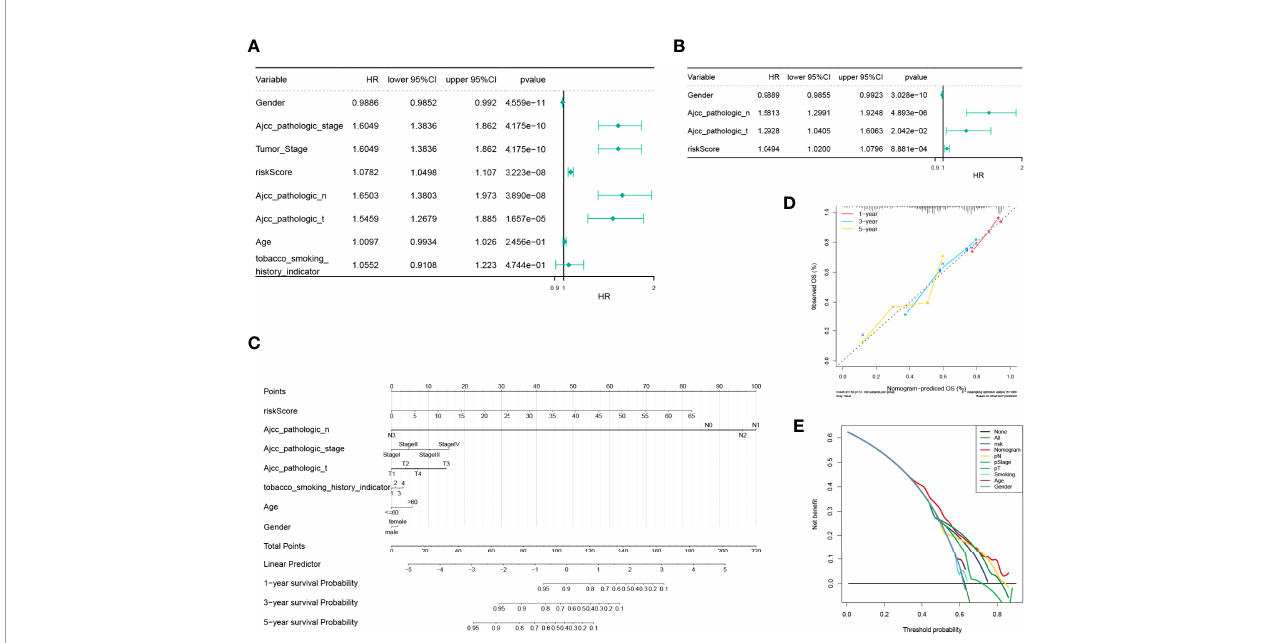
FIGURE 8 | Independent prognostic analysis of the risk model and construction and veri fi cation of the survival prediction sequence diagram. (A) An independent prognosis of univariate Cox analysis showed that risk score, sex, American Joint Committee on Cancer (AJCC) pathologic stage, tumor stage, AJCC pathologic N stage, and AJCC pathologic T stage had a prognostic value for overall survival in lung adenocarcinoma. (B) Independent prognosis of multivariate Cox analysis, risk score, and gender, and pathological N and T staging acted as independent prognostic factors. (C) Line chart of the clinical factors; these variables are visualized in the nomogram. In tobacco smoking history indicator, 1 represents lifelong non-smoker (<100 cigarettes smoked in a lifetime), 2 represents current smoker (includes daily smokers non-daily/occasional smokers), 3 represents current reformed smoker for >15 years, 4 represents current reformed smoker for ≤ 15 years. (D) Line chart 1-, 3-, and 5-year calibration curve. The calibration curves indicated that the nomogram exhibited a satisfactory agreement between the predicted and observed values for 1-, 3-, and 5-year survival rates. (E) The 5-year decision-making curves of the line chart and other clinical traits are presented. The abscissa indicates the threshold probability. In the risk assessment tool, the probability of patient i being diagnosed with the disease is recorded as Pi; when Pi reaches a certain threshold (recorded as Pt), it is de fi ned as positive, and treatment is initiated. There are patient-treated bene fi ts (regarded as bene fi ts) as well as patient- treated injuries and untreated losses (regarded as disadvantages). The ordinate is the net bene fi t, where the pros minus the cons. Different oblique lines in the chart represent different clinical diagnostic